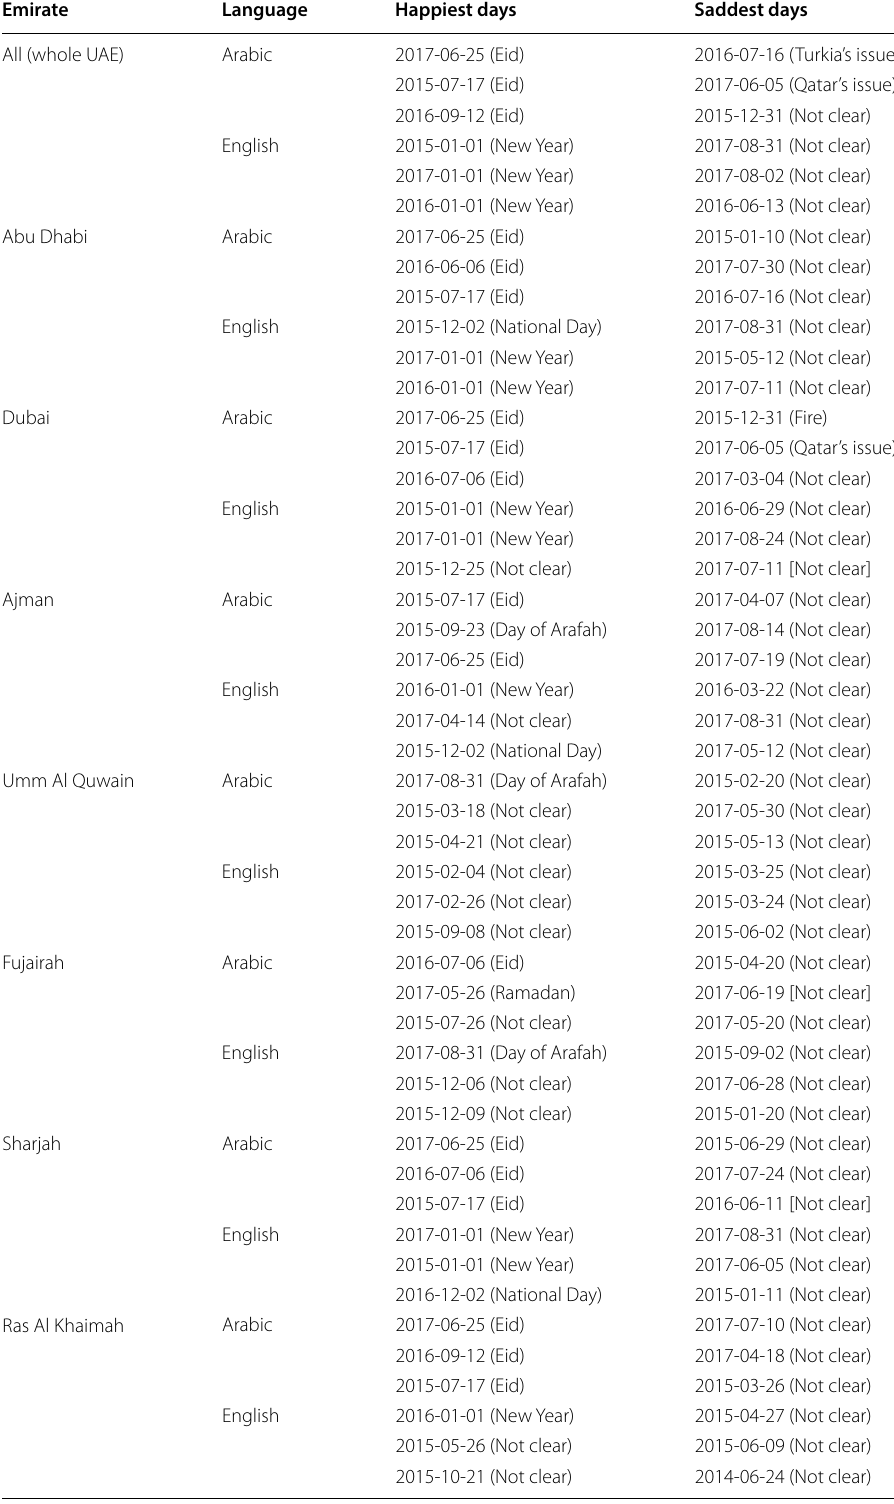
Table 2 Dates and the main events associated with Arabic and English tweets Emirate Language Saddest days All (whole